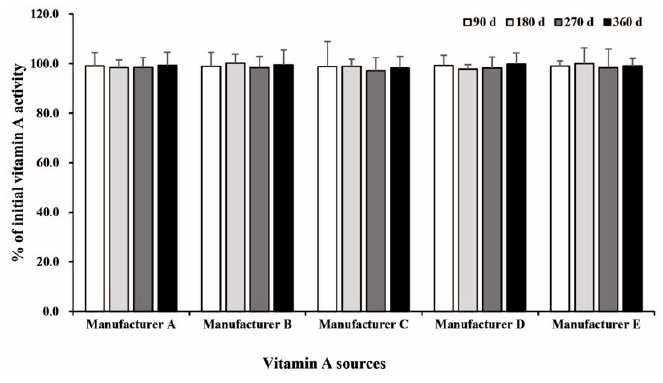
Figure 1. Mean (± standard deviation), n = 6 per treatment group. Effects of storage time and vitamin A source on residual vitamin A activity (% of initial) in vitamin premixes for suckling pigs. The p values relate to vitamin premix (time × source, NS; time, NS; source, NS). NS represents not significant.